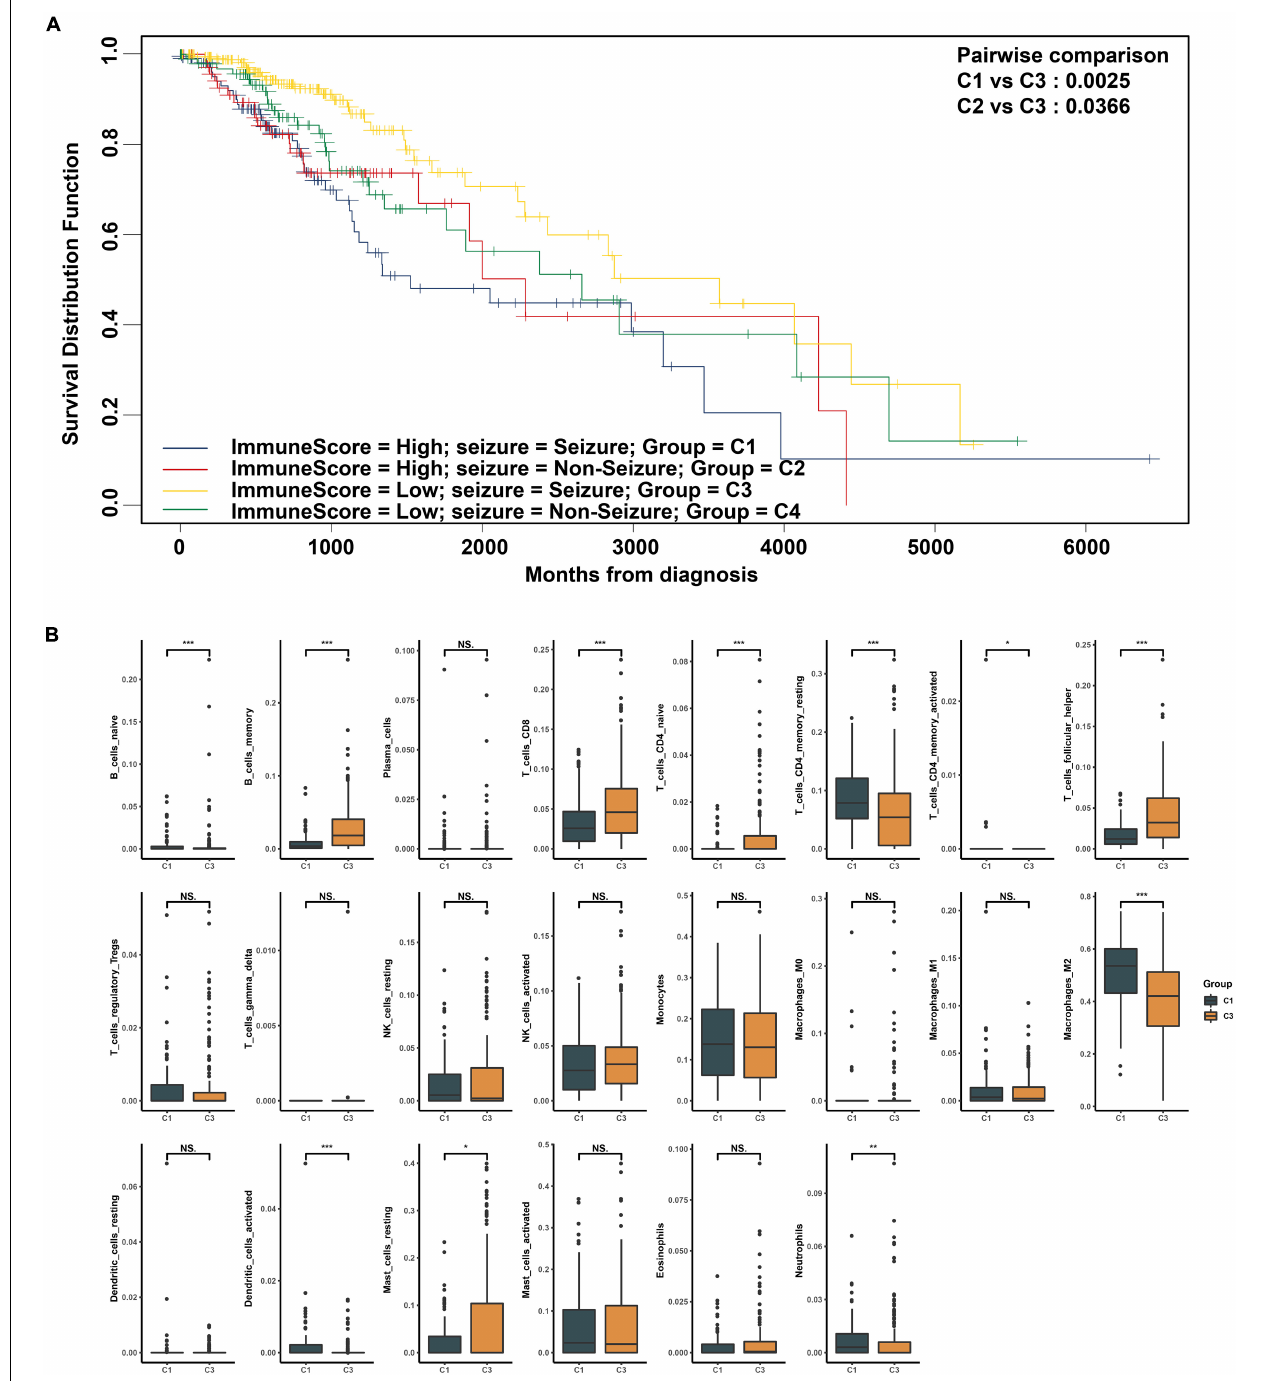
FIGURE 2 | (A) Comparison of survival rate of low-grade glioma (LGG) subgroups differentiated by seizure and immune score. (B) Comparison of 22 immune cell components between high and low immune score groups in LGG patients with epilepsy. * p < 0.05, ** p < 0.01, *** p < 0.001.